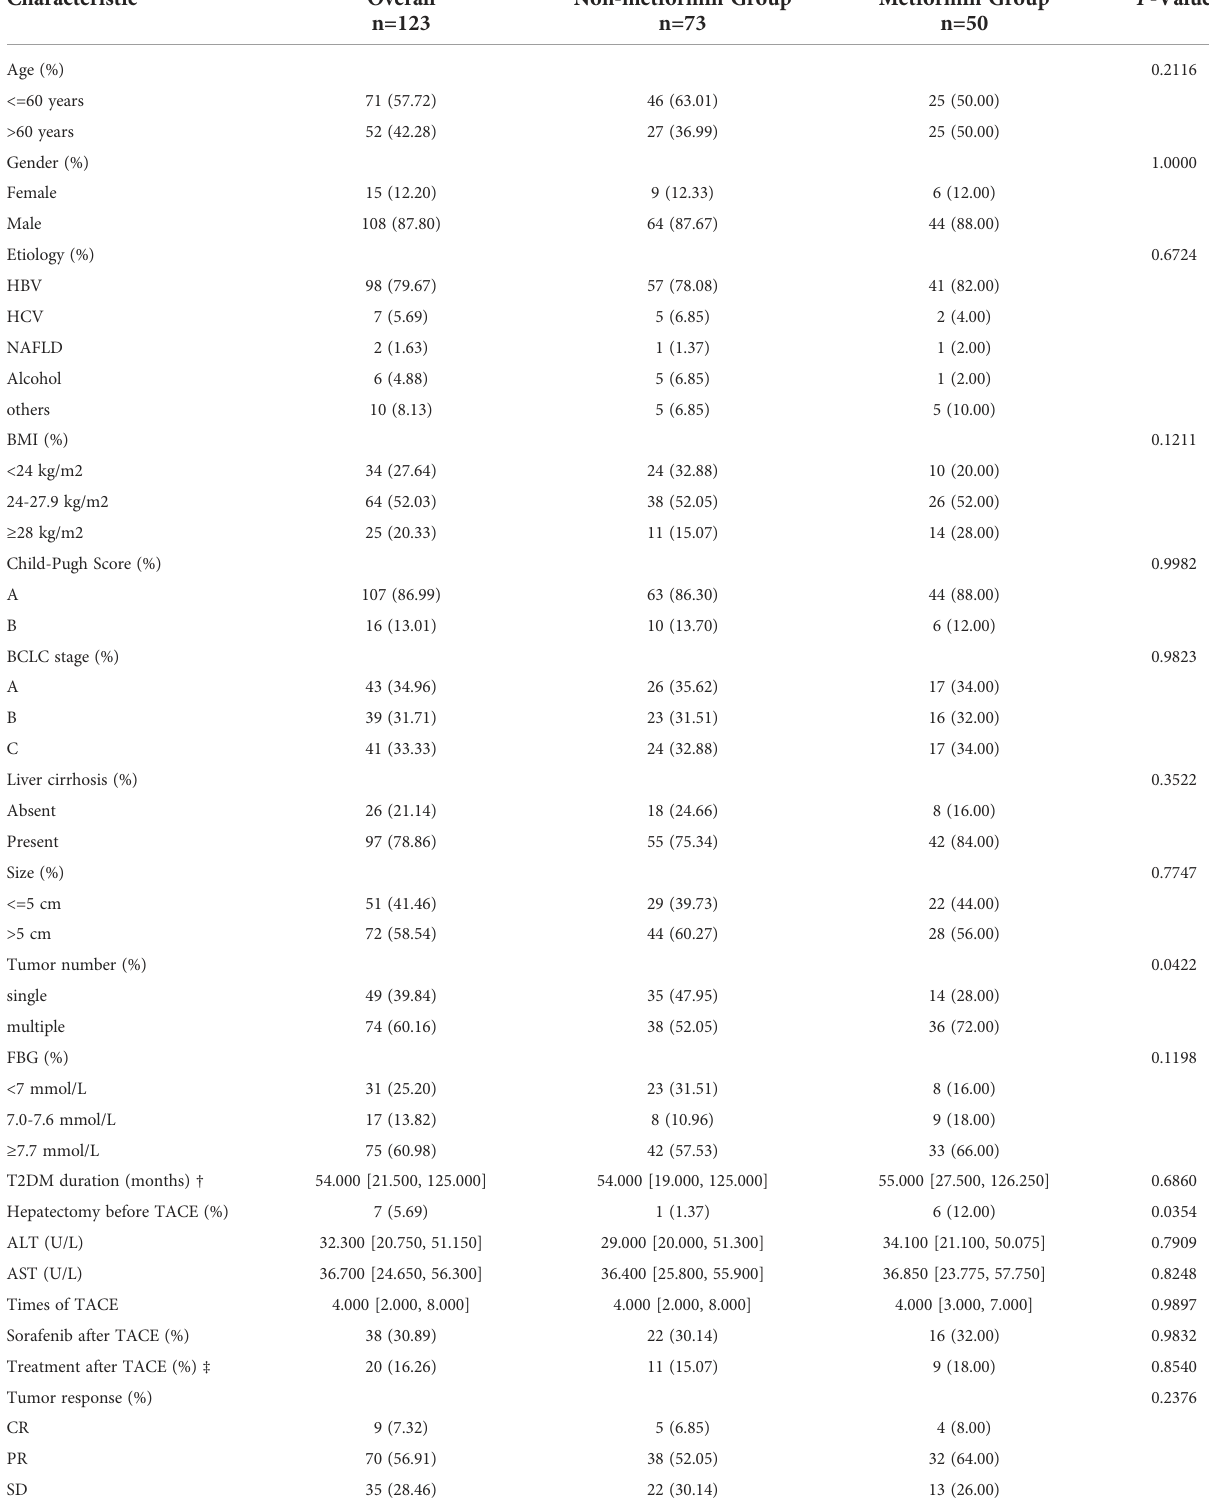
TABLE 1 Clinical characteristics between the metformin group and the non-metformin group in the whole cohort.